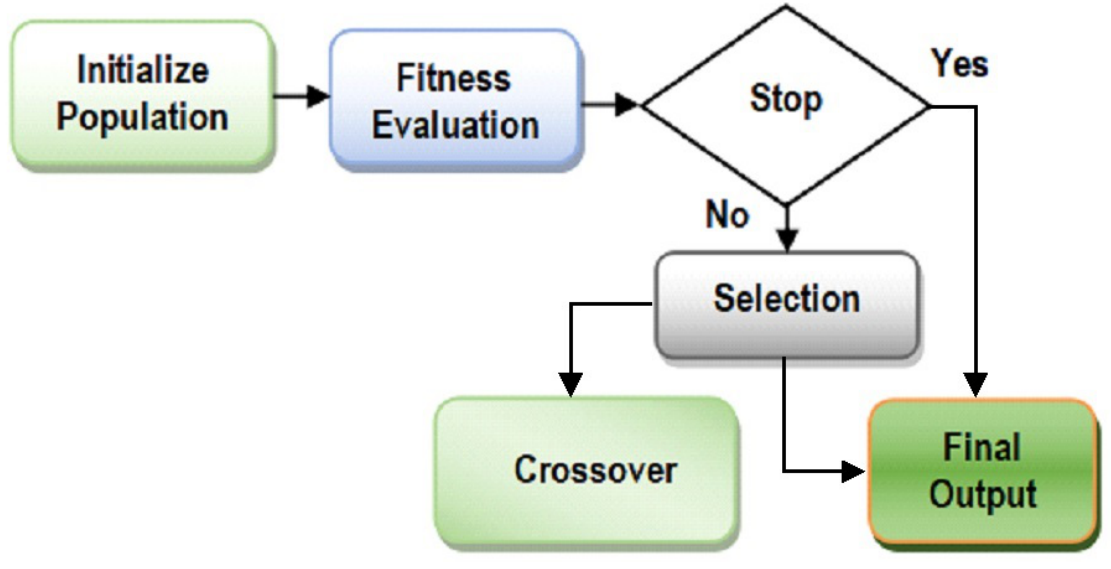
Figure 1. Overview of Genetic